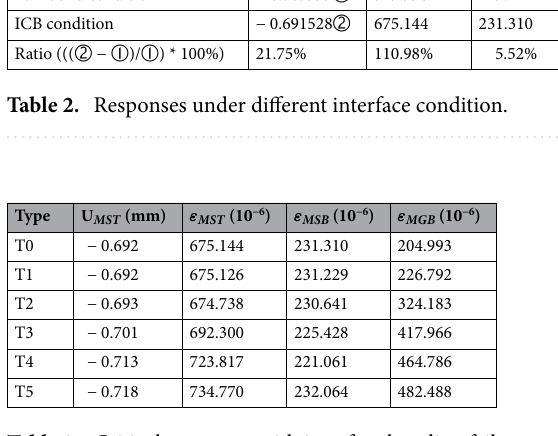
Table 3. Critical responses with interface bonding failure at the high